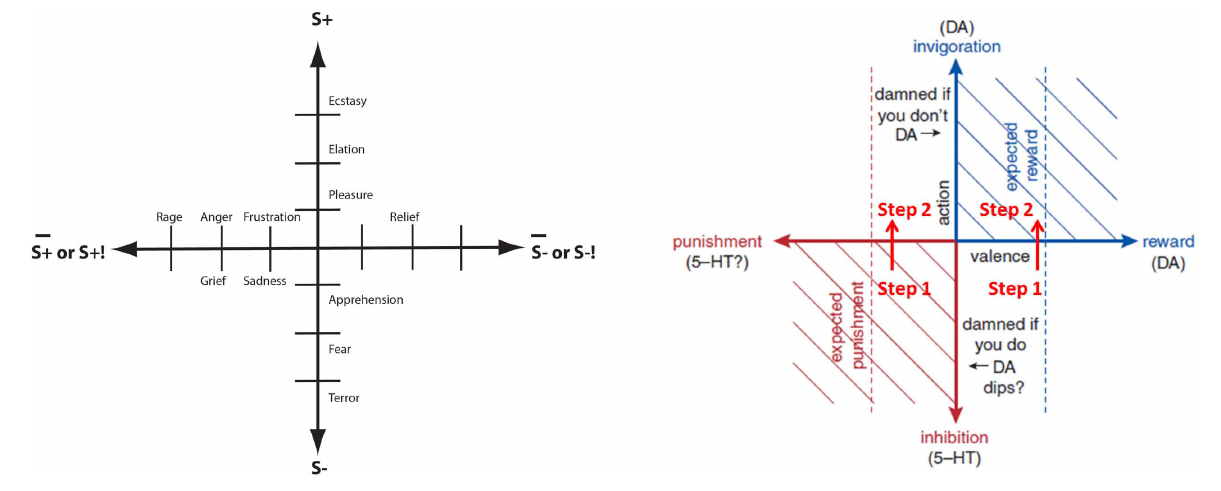
FIGURE 8 | Reinforcement–contingent emotional dimensional models. Left: Rolls’ (1999) dimensional model of emotion-based on omission (! | − ) or fulfillment ( + | − ) of reinforcement. Reprinted with permission. Right: adaptation of Boureau and Dayan (2010) model (step 1 and step 2, and red arrows denoting step transitions have been added). The Rolls model can be mapped onto the Boureau and Dayan model